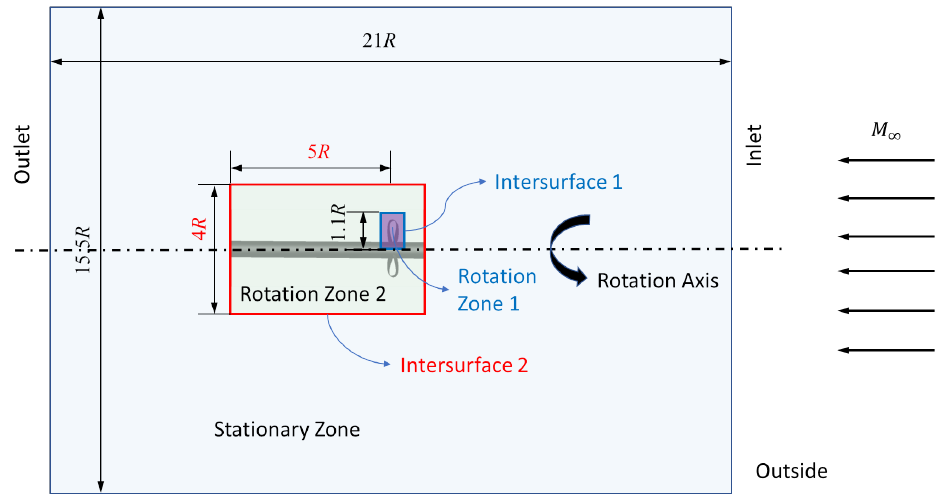
Figure 9. The computational domain used for the CAA